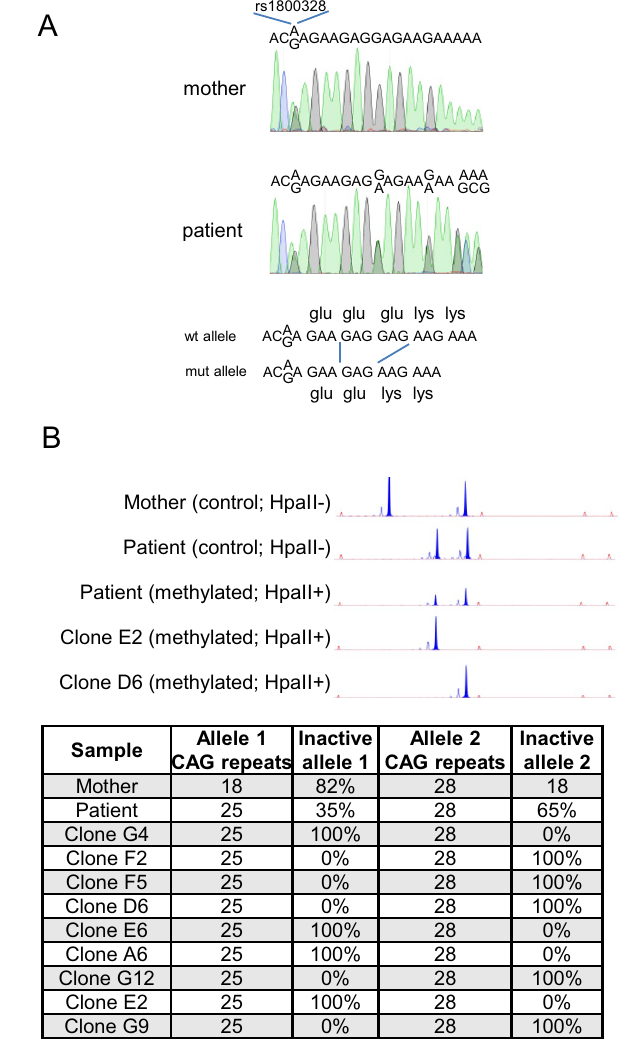
Figure 1. Derivation of clonal populations of HDF expressing either maternally or paternally inherited X chromosome from a female heterozygous patient of OTCD. ( A ) Biallelic genomic sequence corresponding to a region of exon 8 of the OTC gene isolated from the mother and the patient. Mother’s and patient’s region contains SNP rs1800328 in heterozygosity. Patient´s sequence is compatible with heterozygous GAG deletion in position 814–816 or 817–819. ( B ) X chromosome inactivation in genomic DNA samples from mother´s buccal mucosa, patient fibroblasts and 9 clonal